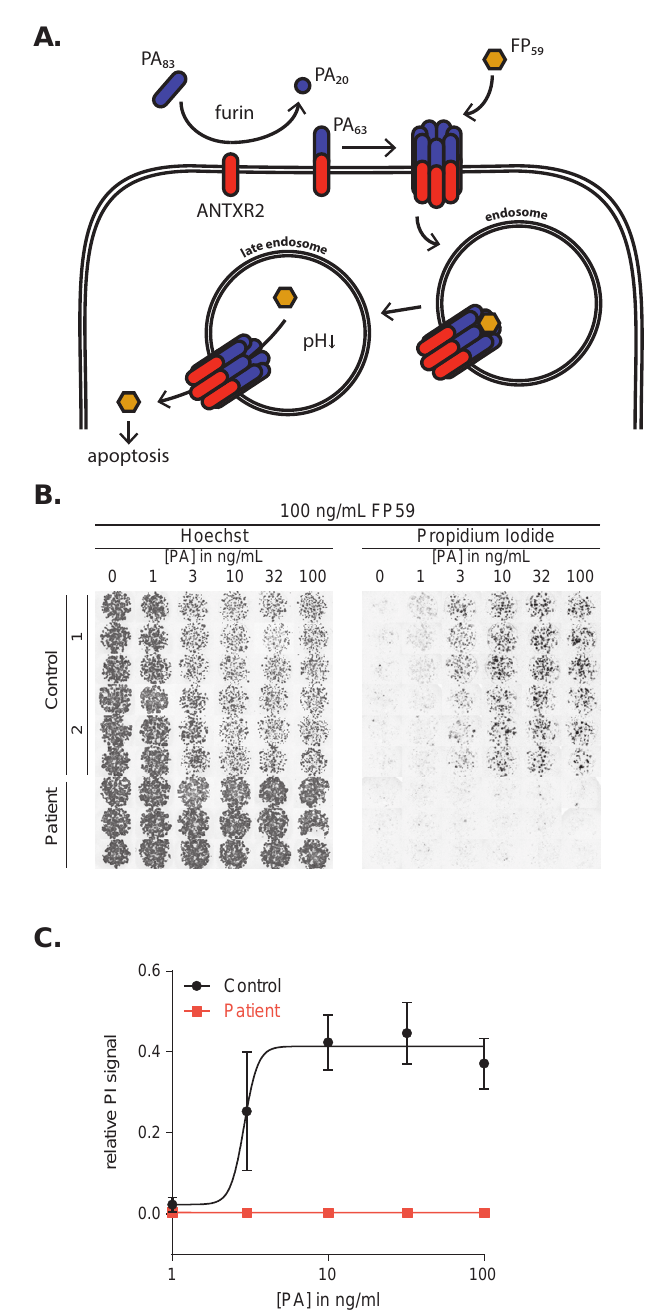
Figure 4. The c.155C > T ANTXR2 mutation results in resistance to anthrax toxin-mediated cell death. ( A ) A schematic overview of the anthrax toxin mechanism of action, adapted from Deuquet et al. [20]. Anthrax toxin PA83 Is cleaved by furin to PA63, which binds to the vWA domain in ANTXR2. Oligomerization leads to pore formation in the cell membrane, which is promoted by the LF-derivative FP59. This allows internalization of the complex, where it is degraded in the late endosome by low pH. FP59 is then released in the cytosol and causes apoptosis. ( B ) Hoechst and PI stainings from the anthrax toxin assay performed on control and patient organoids grown on EM. ( C ) Quantification of the relative PI signal as a measure for cell death. Mean ± SD for n = 2